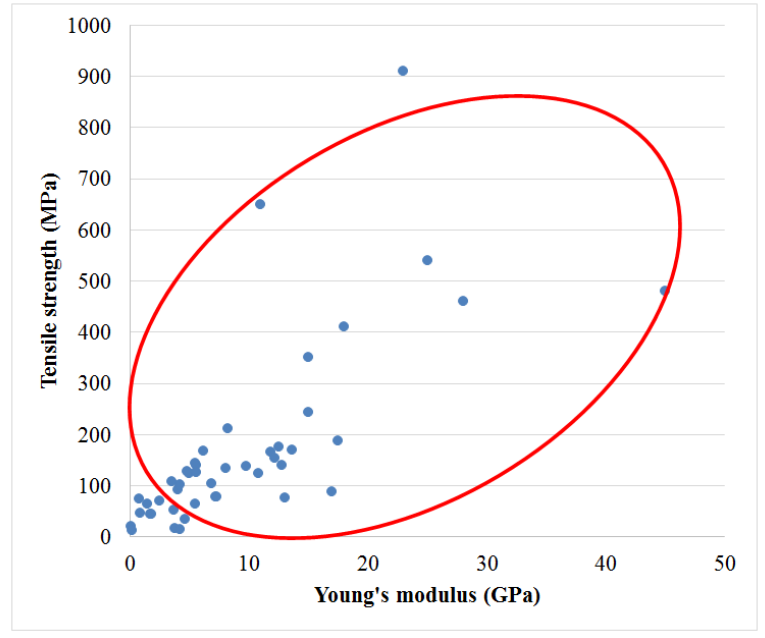
Figure 4. Mechanical properties of ACCs (tensile versus mechanical strength). The plot has been produced using data presented in Table produced using data presented in Table S1.